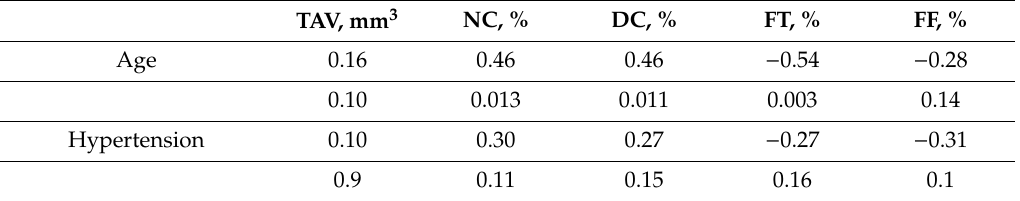
Table 2. Association between atherosclerotic risk factors, lipids and lipoproteins, biomarkers and plaque components, as assessed by intravascular ultrasound and virtual histology.